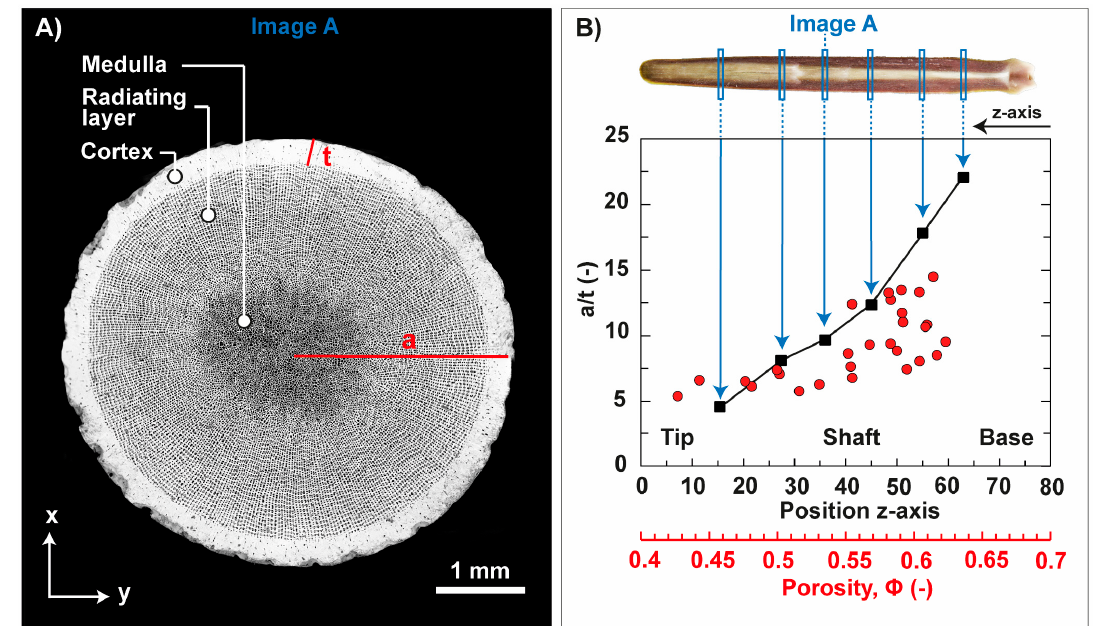
Figure 10. Quantity of the cortex in the microstructure of the spine of Phyllacanthus imperialis . ( A ) The quantity of the cortex is expressed as a/t ratio. The a/t ratio is composed of the radius of the spine segment, a, which was normalized by the cortex thickness, t. The quantity of the a/t ratio and the porosity at specific positions in the spine is demonstrated in ( B ) as black squares and red circles, respectively.